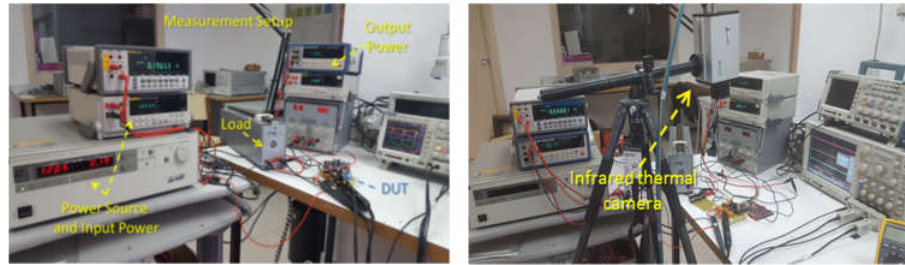
Figure 14. Setup for the winding loss measurement in the flyback transformer. Table 3. Measured operating conditions in the flyback converter prototype.